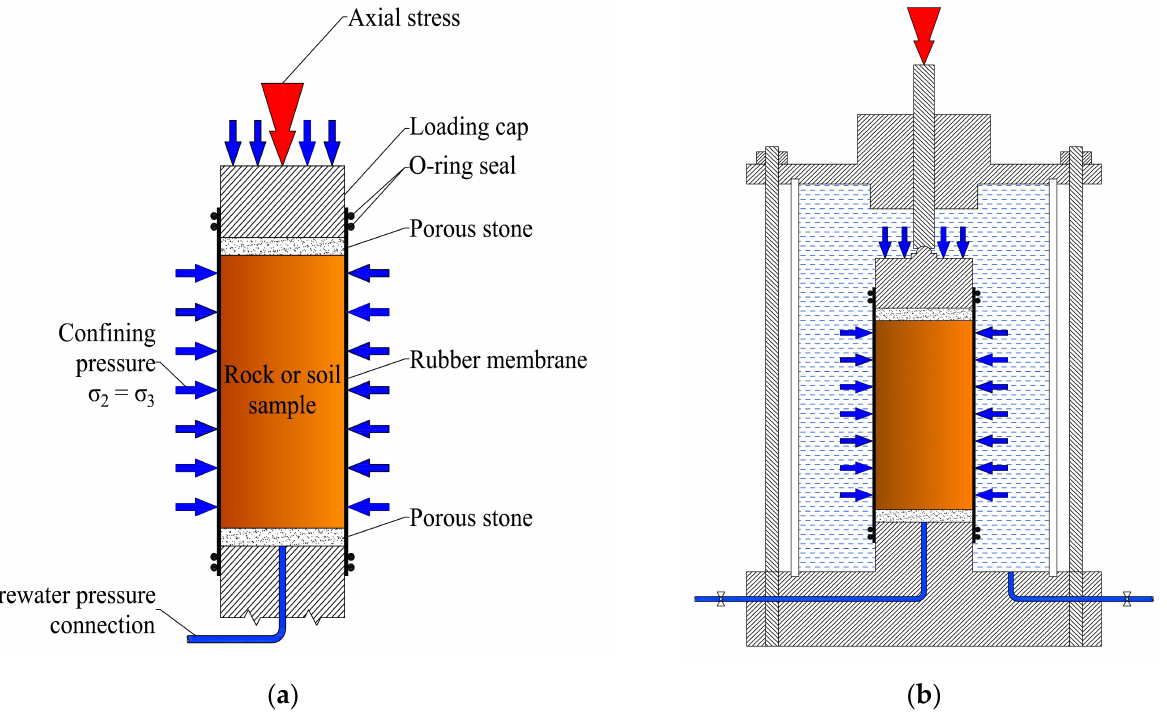
Figure 9. Triaxial test: ( a ) rock or soil sample in triaxial test and ( b ) triaxial cell with sample [25,28,29].